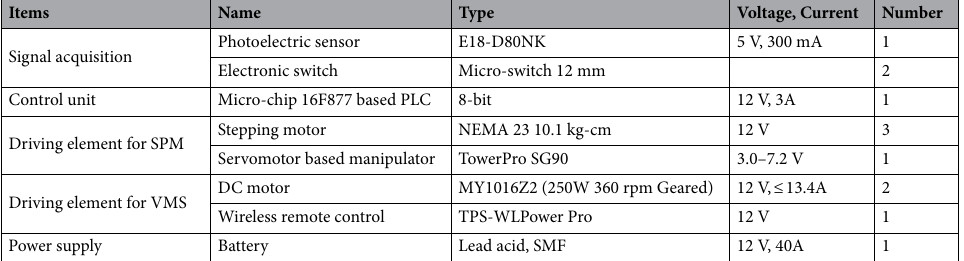
Table 2. Main hardware design used in the robotic